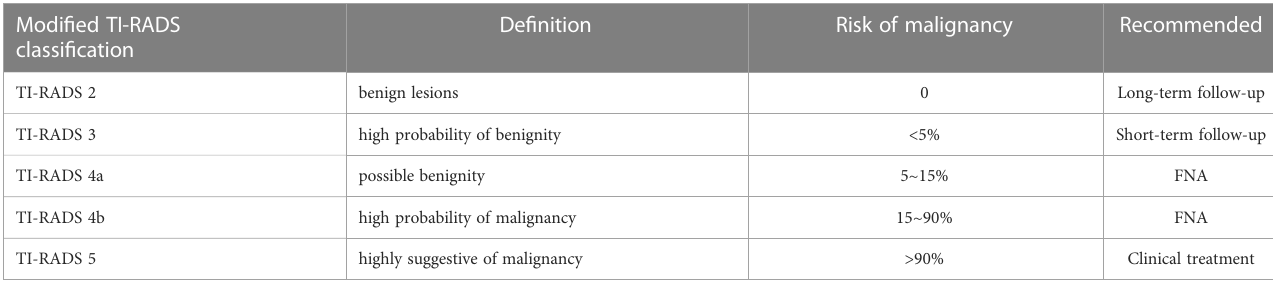
TABLE 1 Modi fi ed TI-RADS diagnostic criteria in combination with CEUS. Modi fi ed TI-RADS classi fi cation